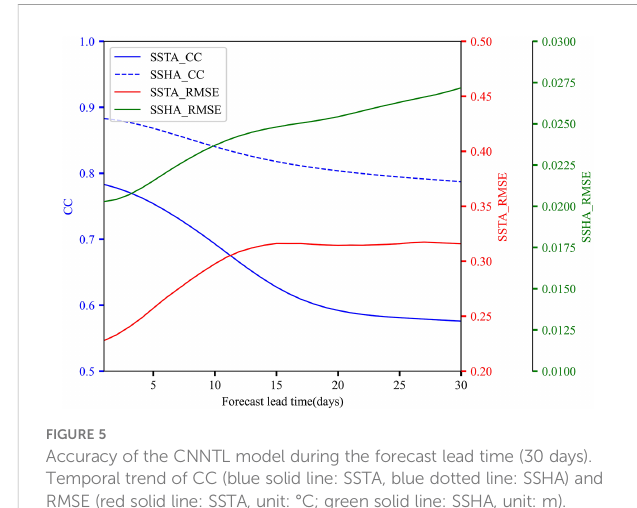
FIGURE 5 Accuracy of the CNNTL model during the forecast lead time (30 days). Temporal trend of CC (blue solid line: SSTA, blue dotted line: SSHA) and RMSE (red solid line: SSTA, unit: °C; green solid line: SSHA, unit: